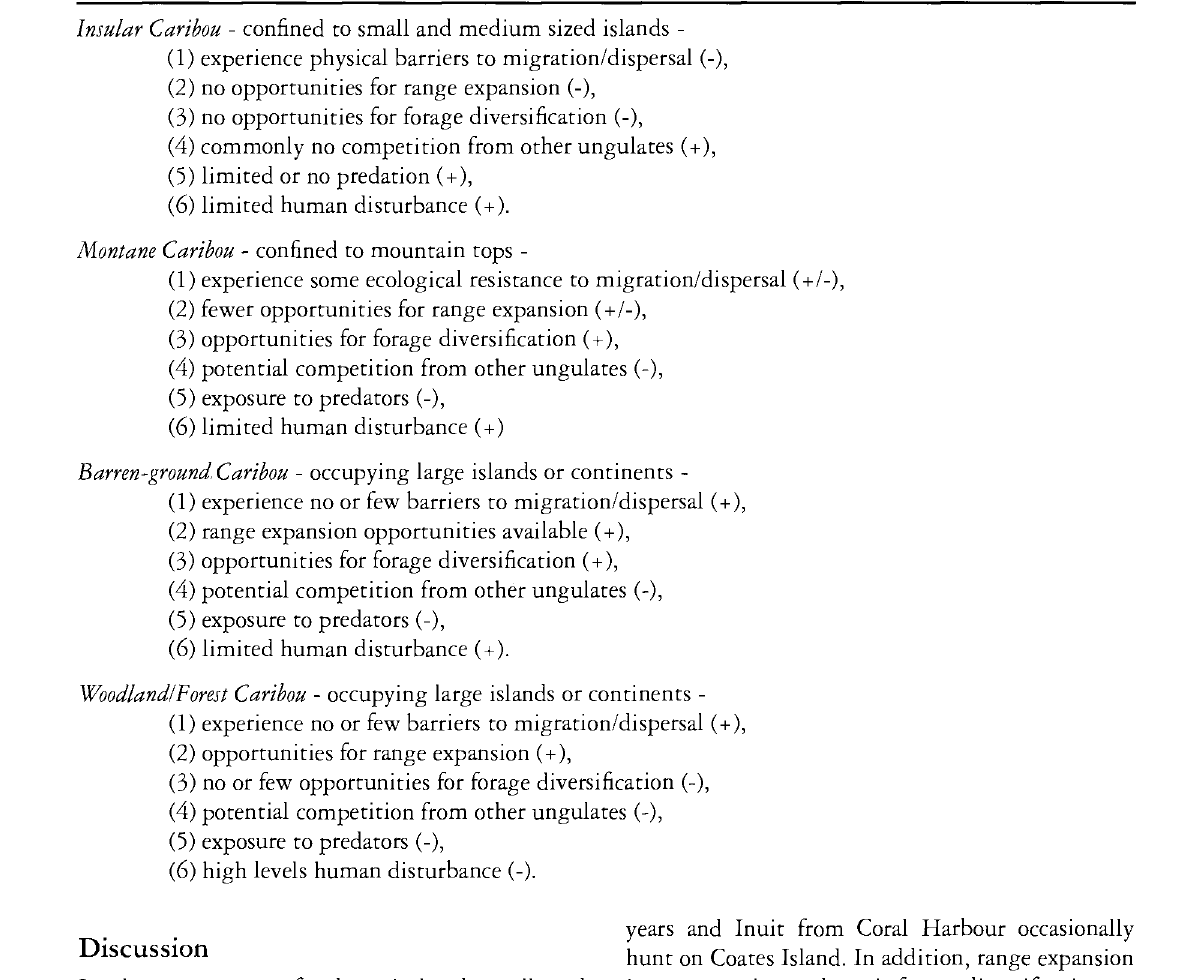
Table 5. A summary of ecological constraints (-) and releases ( + ) impacting the four caribou ecotypes. Insular Caribou - confined to small and medium sized islands